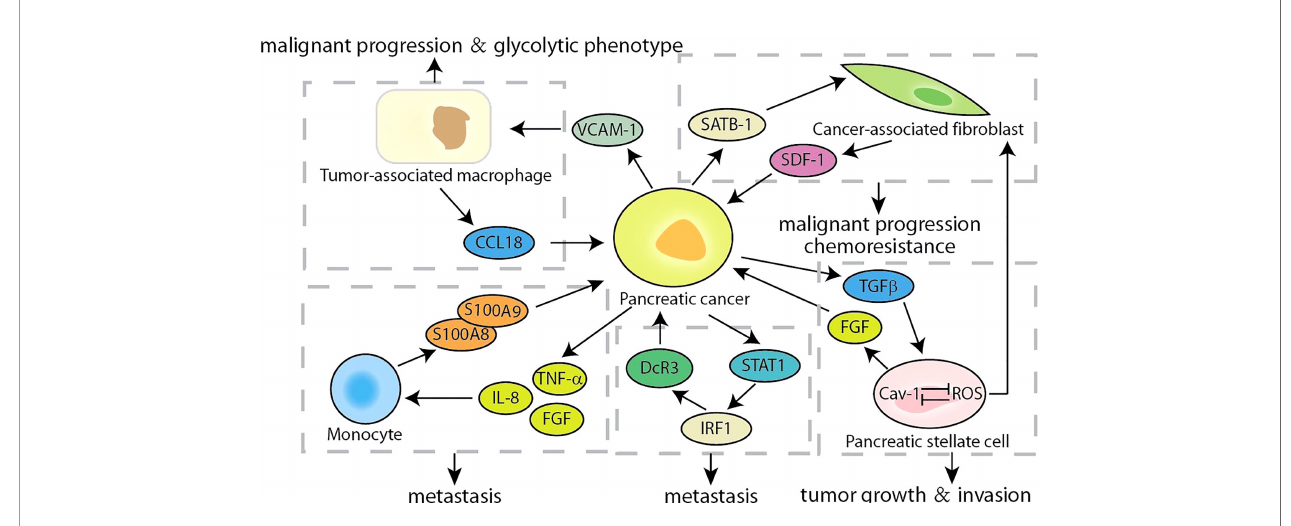
FIGURE 6 | Summary of the crosstalk of cells related feedback loops in pancreatic cancer.